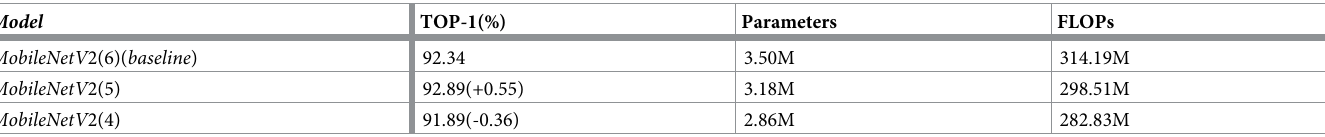
Table 3. Results on